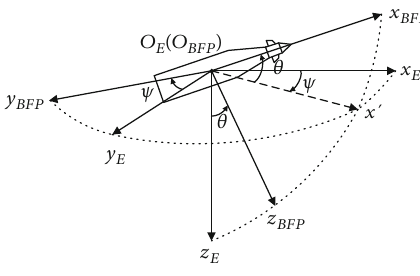
Figure 2: The body fi xed plane reference